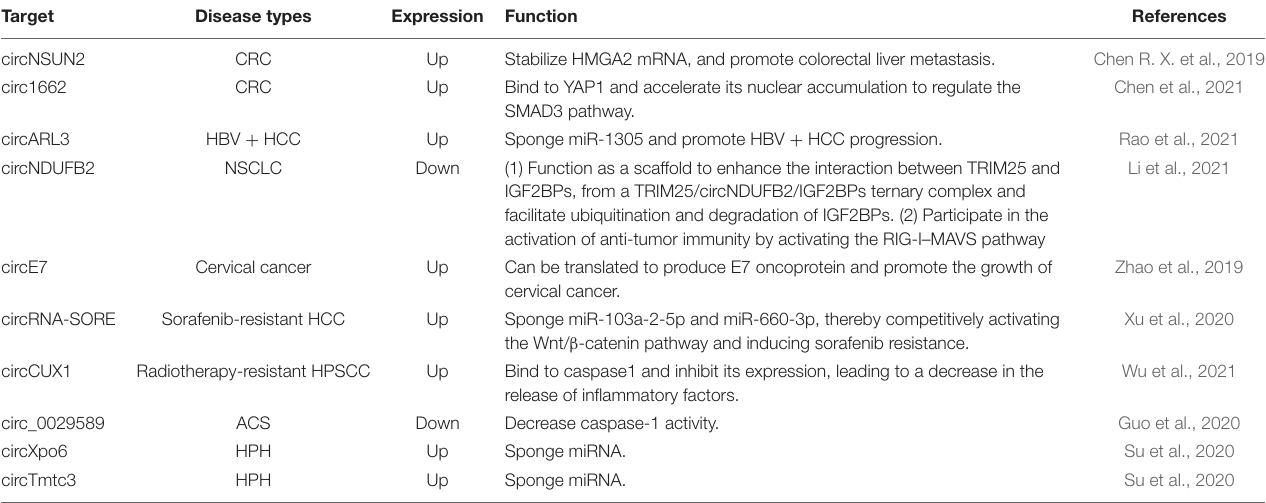
TABLE 1 | m6A-modified circRNAs as the potential therapeutic target of different diseases based on current